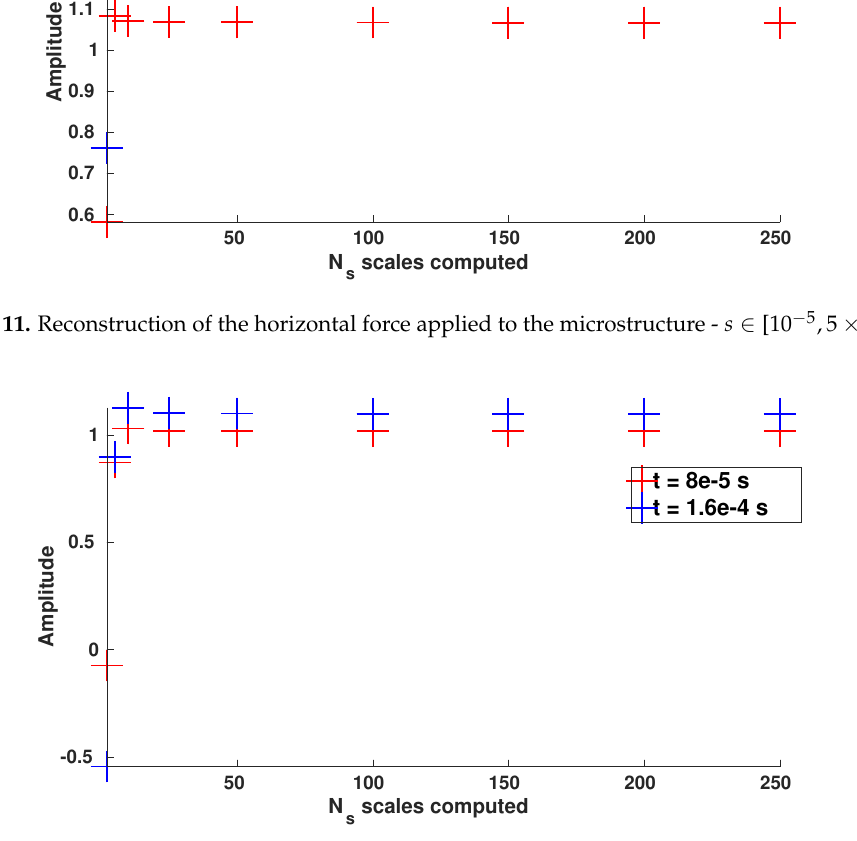
Figure 12. Reconstruction of the horizontal force applied to the microstructure - s ∈ [10 − 5 , 10 − 3